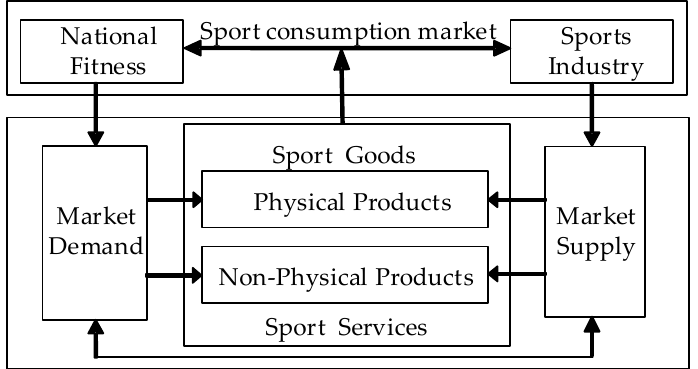
Figure 1. The symbiosis system of national fitness and the sports industry.